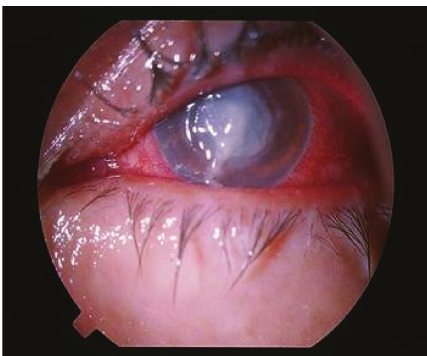
Figure 2: Conjunctival injection, di ff use central corneal infiltration and marked discharge in the left eye at initial presentation.